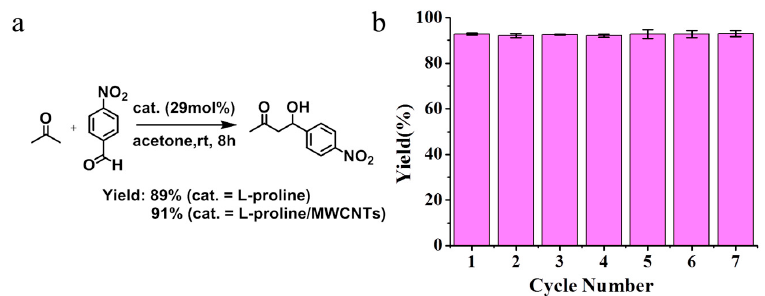
Figure 4. ( a ) Aldol reaction of acetone and 4-nitrobenzaldehyde catalyzed by L-proline or L-proline/MWCNTs and ( b ) recycling and reuse bar graph of L-proline/MWCNTs catalyst in Aldol reaction.